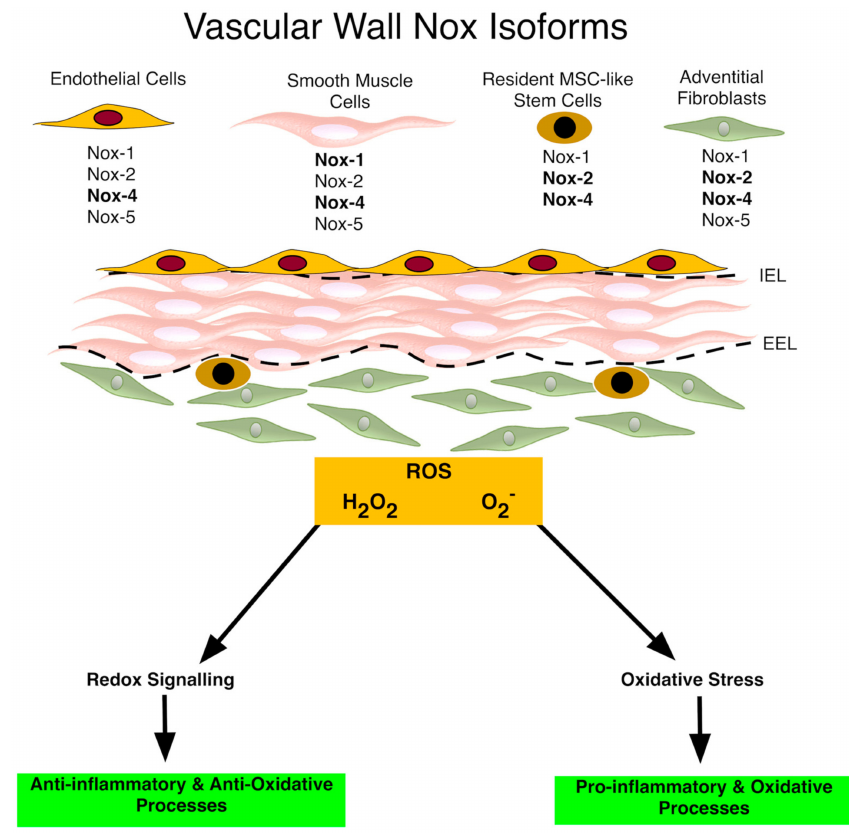
Figure 1. Nox enzymes within the vasculature. The schematic depicts the Nox enzymes within the vascular wall. All three layers of the vascular wall [intima (i.e., endothelial cells), media (i.e., smooth muscle cells), and adventitia (i.e., fibroblasts and macrophages)] express Nox family members. Nox4 is the predominant isoform in endothelial cells, Nox1 and Nox4 in smooth muscle cells, Nox4 in fibroblasts, and Nox2 and Nox4 in stem cells. Nox-derived O 2 − avidly reacts with NO. Nox-derived ROS also affect the extracellular matrix and the external (EEL) and internal elastic lamina (IEL), influence gene expression and are involved in cell proliferation, migration and differentiation that lead to vascular disease progression